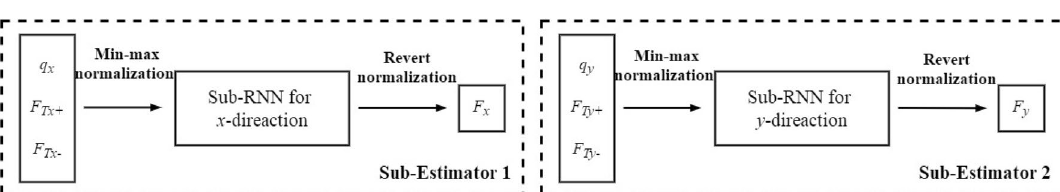
Figure 8. Comparison of the errors of each force estimator.